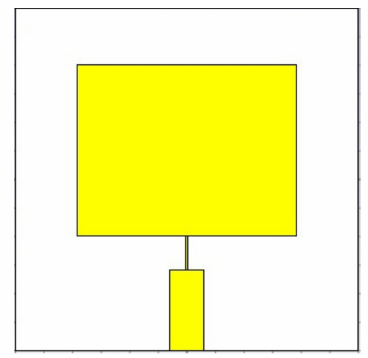
Figure 2. Designed 2.45 GHz Microstrip Patch Antenna Sensor ready for